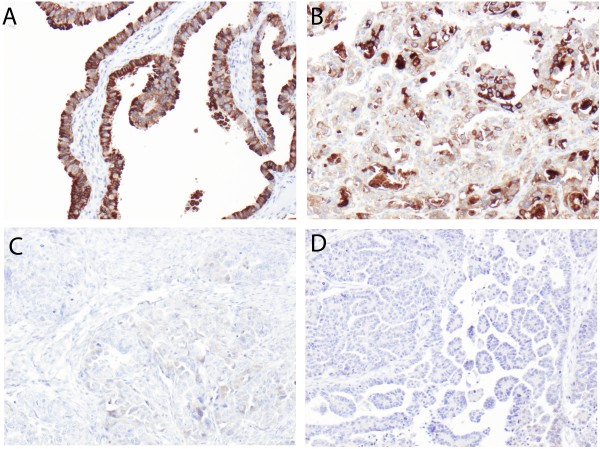
Immunohistochemical images of PIGR staining in fallopian tubes, primary and metastatic epithelial ovarian cancer. Sample images (10× magnification) representing immunohistochemical expression of PIGR, described as cytoplasmic score, i.e. a multiplier of fraction (0-4) and intensity (0-3) of staining: (A) Fallopian tube and (B) primary tumour with strong expression (score 12 and 12, respectively), (C) primary tumour with weak (score 3) and (D) matched metastasis with negative expression (score 0).